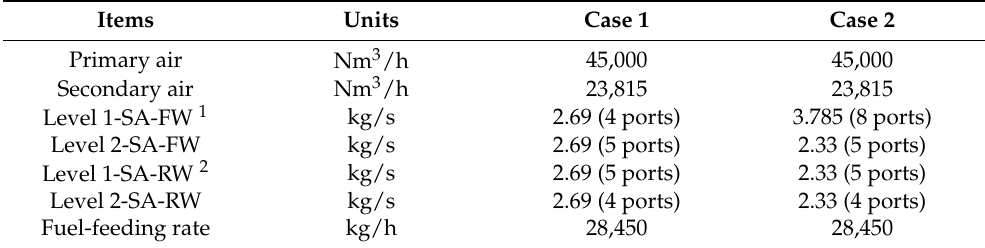
Table 4. Key operating parameters of the numerical